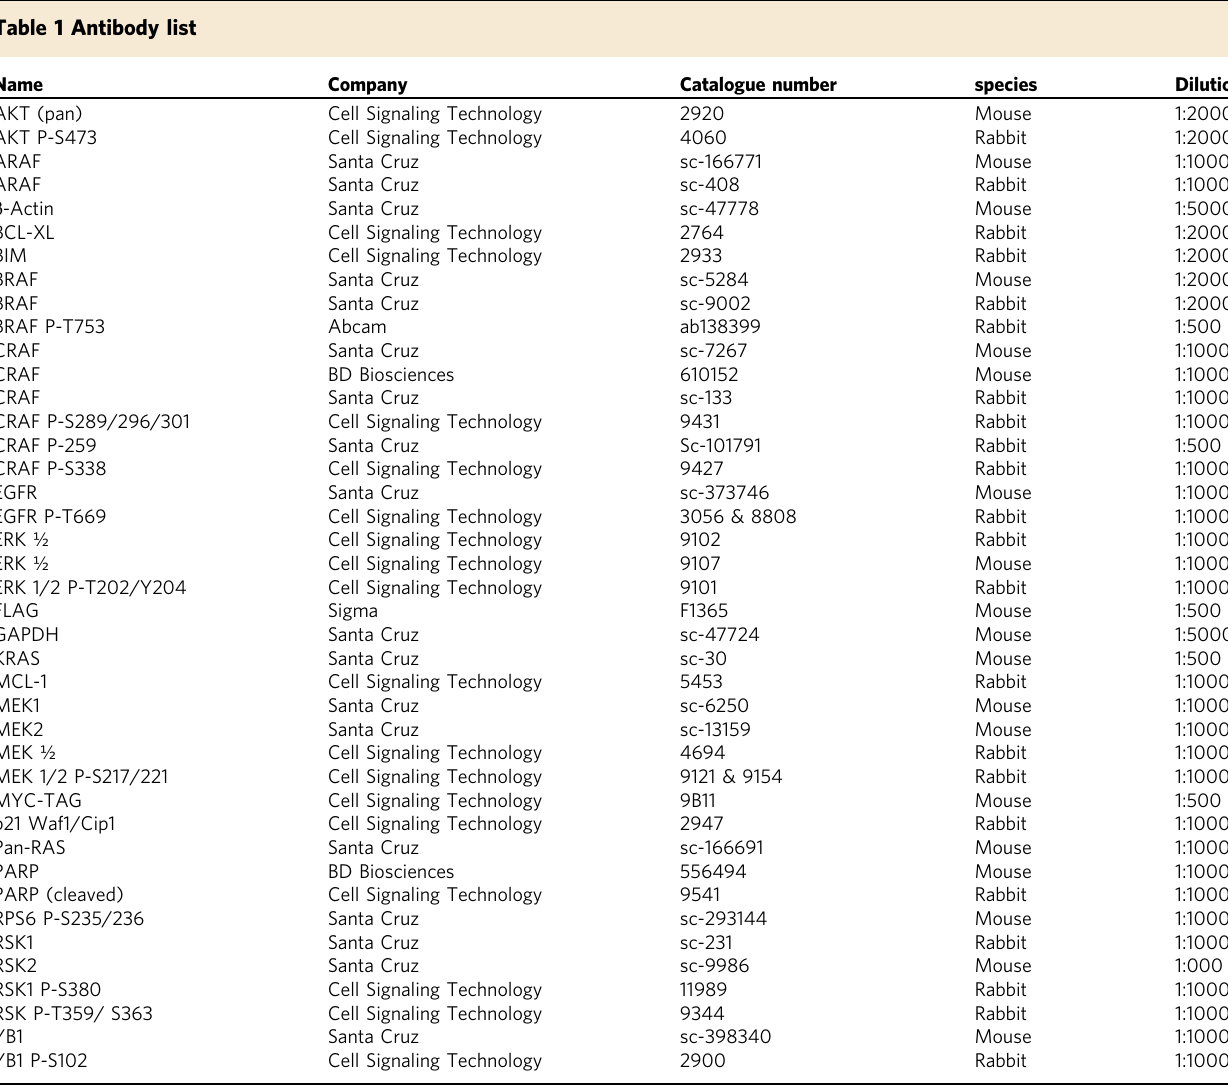
Fig. 6 Combined genetic inhibition of SHOC2 and MEKi treatment promote apoptosis in RAS-mutant cells. a – b SHOC2 deletion lowers the concentration of MEKi required to prevent re-growth of A427 cells after inhibitor withdrawal. Incucyte growth curves of Parental or SHOC2 KO A427 cells grown in the presence of a single addition of the indicated concentrations of Trametinib ( a ) or Selumetinib ( b ). After 96 h the inhibitor was washed out and cell growth measured for an additional 4 days by incucyte imaging. c SHOC2 deletion lowers the concentration of the MEKi required to induce apoptosis in H358 cells. Parental or SHOC2 KO cells were treated with the indicated concentrations of Selumetinib for 48 h and analysed by FACS after PI and Annexin V staining. Representative pro fi les from n = 2. d Quanti fi cation of ( c ) (mean± SD)( n = 2). e Immunoblot analysis of lysates of H358 cells treated with Selumetinib for 12 h. f Quanti fi cation of cleaved PARP in ( e ). g BIM knockdown diminishes the sensitisation of H358 SHOC2 KO cells to Selumetinib. H358 P and SHOC2 KO cells transfected with SCR or BIM siRNAs were treated with Selumetinib on Day 2 post transfection and cell viability assays performed 4 days later. h – i Combined genetic inhibition of SHOC2 and MEKi treatment promote tumour regressions in A427 xenografts. 2.5*10 6 shSCR or shSHOC2 A427 cells were injected into the fl anks of nude mice and tumours allowed to reach 200 mm³ before treatment with either vehicle or 0.4 mg/kg Trametinib. h Change in tumour volume after 28 day treatment is presented as a waterfall plot of individual tumours. Signi fi cance is determined using a two tailed t -test ∗ p < 0.05, ∗∗ p < 0.01 or ∗∗∗ p < 0.001. i Tumour growth over time, Trametinib treatment was stopped after 28 days and tumour growth measured for